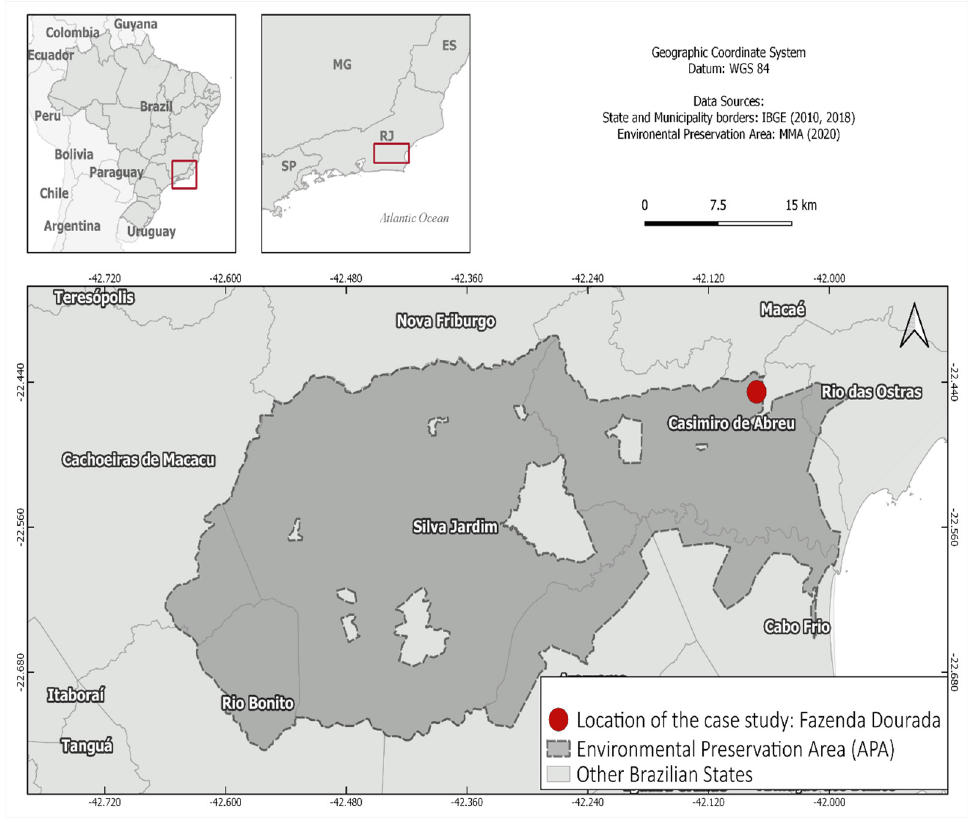
Figure 1. Location of the Fazenda Dourada, Rio de Janeiro State, Brazil. Source: International Institute for Sustainability. (Map of the case study was generated by software QGIS 3.4 “MADEIRA”).